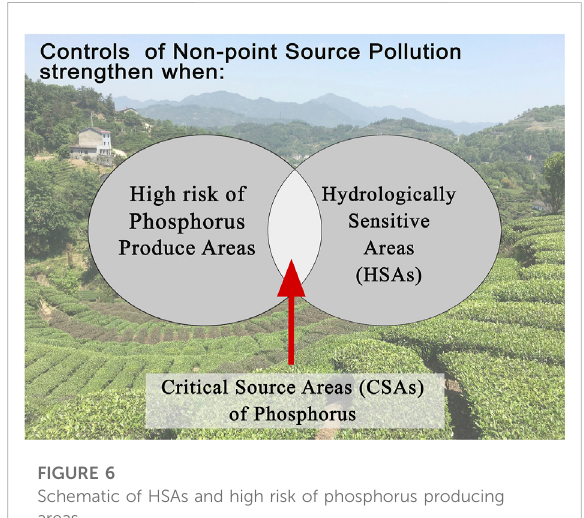
FIGURE 6 Schematic of HSAs and high risk of phosphorus producing